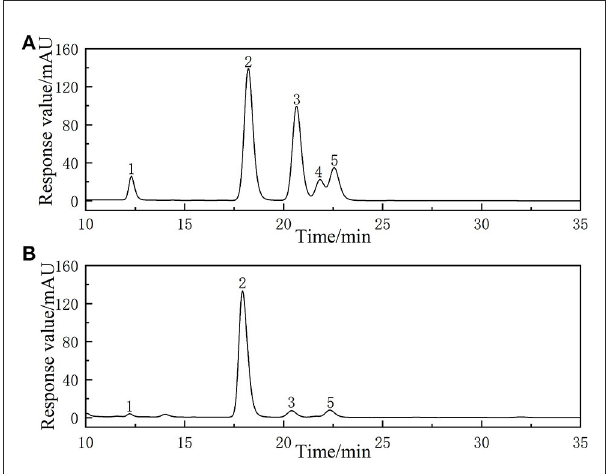
FIGURE5 The HPLC chromatogram of (A) reference monosaccharides and (B) monosaccharides composition of ALPs.